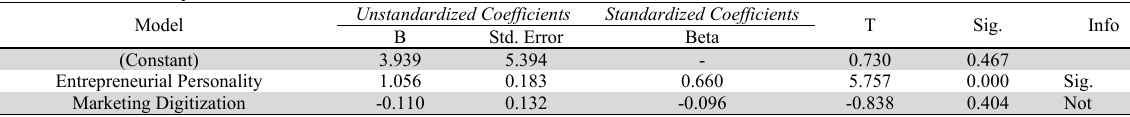
Table 2 MRA Model I I Analysis